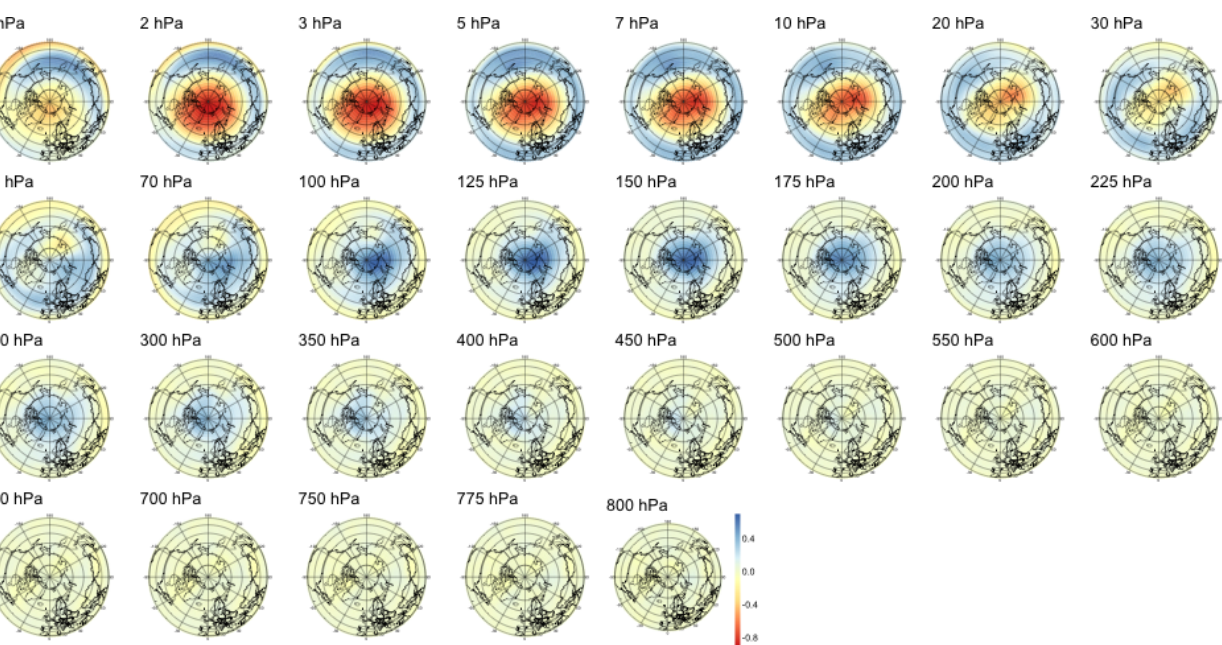
Weather Clim. Dynam., 4, 287–307, 2023